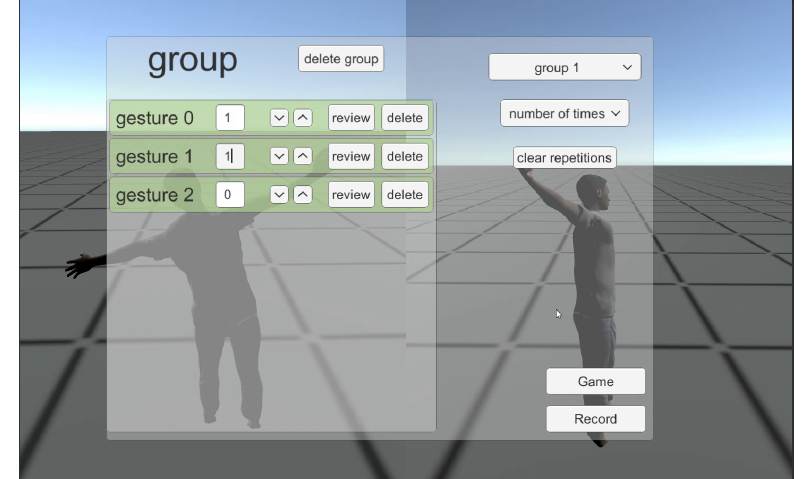
Figure 6. Dashboard for therapists to input groups of